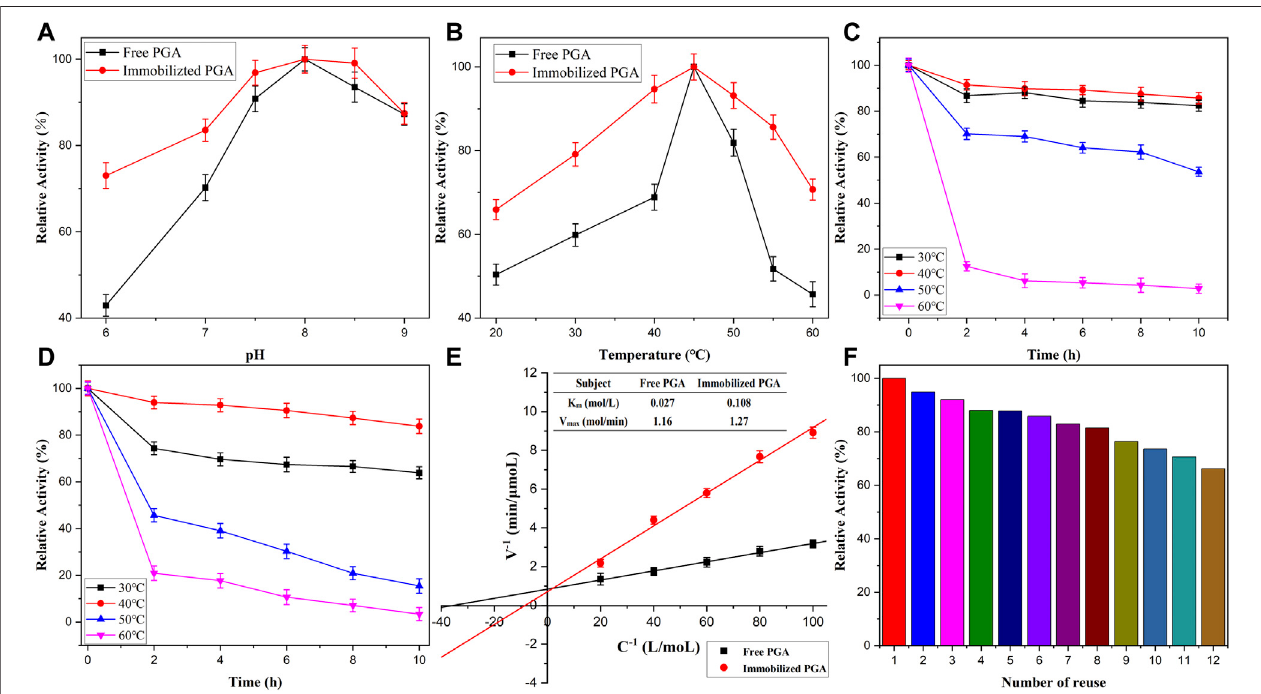
FIGURE6| ThepHvalue (A) ,temperatures (B) ,andthermostabilitiesonfree (C) andimmobilizedPGA (D) ,theLineweaver-Burkdiagram (E) andthereproductivity of immobilized PGA (F) .